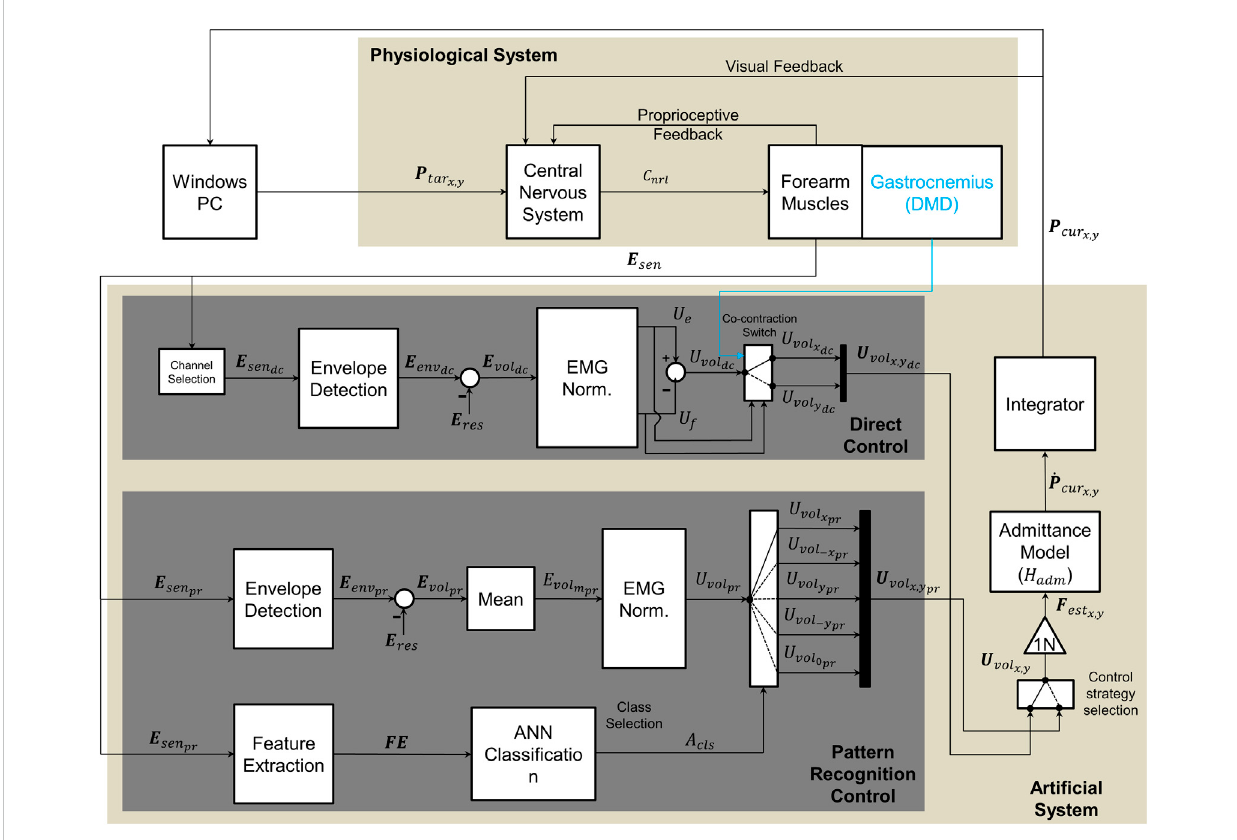
FIGURE 2 Diagram of implemented control methods, adapted from Lobo-Prat et al. (Lobo-Prat et al., 2017a). Bold font style symbols indicate vectors and regular font style symbols indicate scalars. The upper section represents the physiological system (participant), while the lower section represents the experimental system. To perform a movement participant fi rst see the target on the screen ( P tarx,y ). The target is generated by a python script running in thehostcomputer. Thisgeneratesaneuralcommand(C nrl )withtheir centralnervoussystem, whichresults inmuscleactivationatforearmmuscles where sEMG signals ( E sen ) are measured. Intention of the user is decoded from these sEMG signals. In direct control the sEMG signals ( E sendc ) are measured from agonist/antagonist muscle pair from forearm (Flexor Carpi Ulnaris/Extensor Carpi Ulnaris) and the resting sEMG ( E res ) is subtracted to acquire the voluntary sEMG ( E voldc ). The signal is normalized to the maximum voluntary contraction (MVC) and control signals are generated from each muscle (U e ,U f ). A voluntary control signal (U voldc ) is obtained by subtracting the control signal of the fl exor muscle from that of the extensor muscle (reverse for left handed participants). A co-contraction switch, was used to alternate DOF. In case of the DMD participant, an electrode in the gastrocnemius was used to switch (blue line). In pattern recognition control sEMG signals ( E senpr ) are measured from six electrodes placed on forearm (hexagonal grid). Time domain features (FE) were extracted from measured sEMG signals and these features were then used by ANN classi fi er to identify themovementclass(Acls).Thisclassisthenusedtoselectthe fi nalcontrolsignal( U volx,ypr ).Thiscontrolsignal(U volpr )isthenormalizedmeanenvelopeof the six electrodes. In both control methods the estimated voluntary forces (F estx,y ) are used as input to a fi rst order admittance model (H adm ) that resemblesthedynamicsofamass-dampersystem.Theresultingvelocityofthecursor( _ P curx,y )issendtoanintegrator( P curx,y )andthentothewindowsPC to control the position of the cursor on the screen. This motion was sensed by the participants proprioception and by visual feedback and was used to generate new neural commands to reach new target positions ( P tarx,y